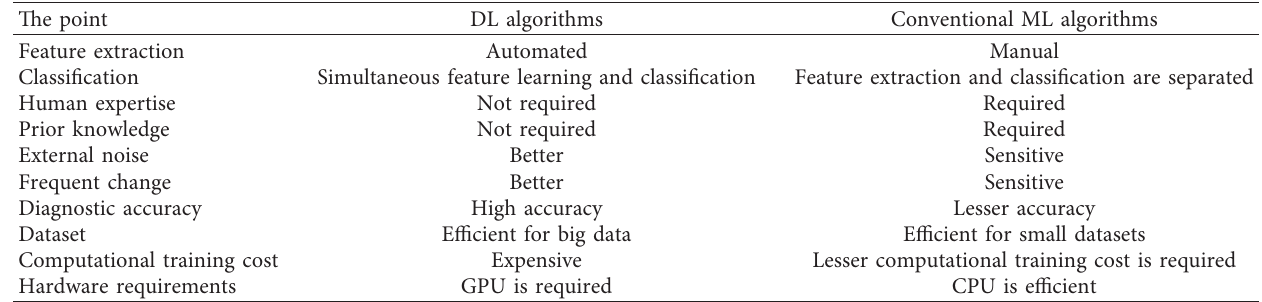
Table 4: DL vs. ML for bearing CM and